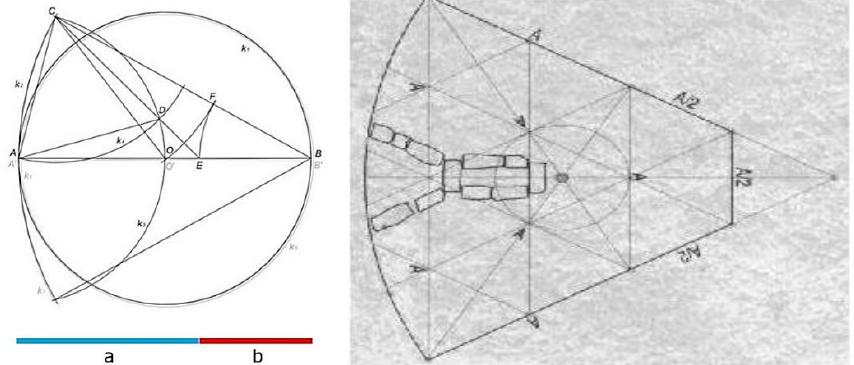
Figure 21. The Euclidean method, the golden-cross section, and the geometric analysis of the foundation of the Lepenski Vir dwelling, as a matter of fact, by no means an interesting coincidence